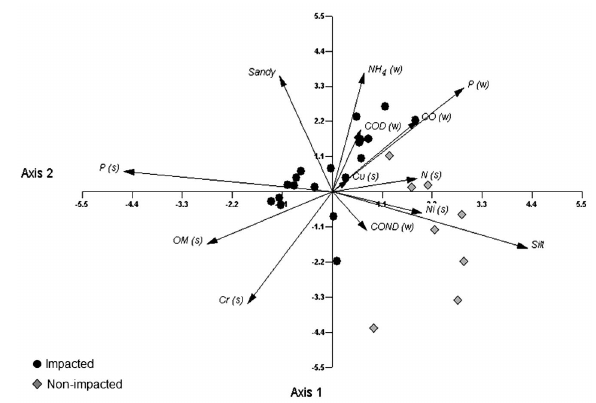
Fig . 6. – CCA ordination plot. In brackets are indications for water characteristics (w) and sediment characteristics (s). COND, elec- trical conductivity; P, total phosphorus; COD, chemical oxygen demand; CO, consumed oxygen; NH , ammonium; OM, organic 4 matter; N, total nitrogen; Cu, copper; Cr, chromium; Ni, nickel. The first and second axes explained 47.12% and 17.2% of the variation, respectively